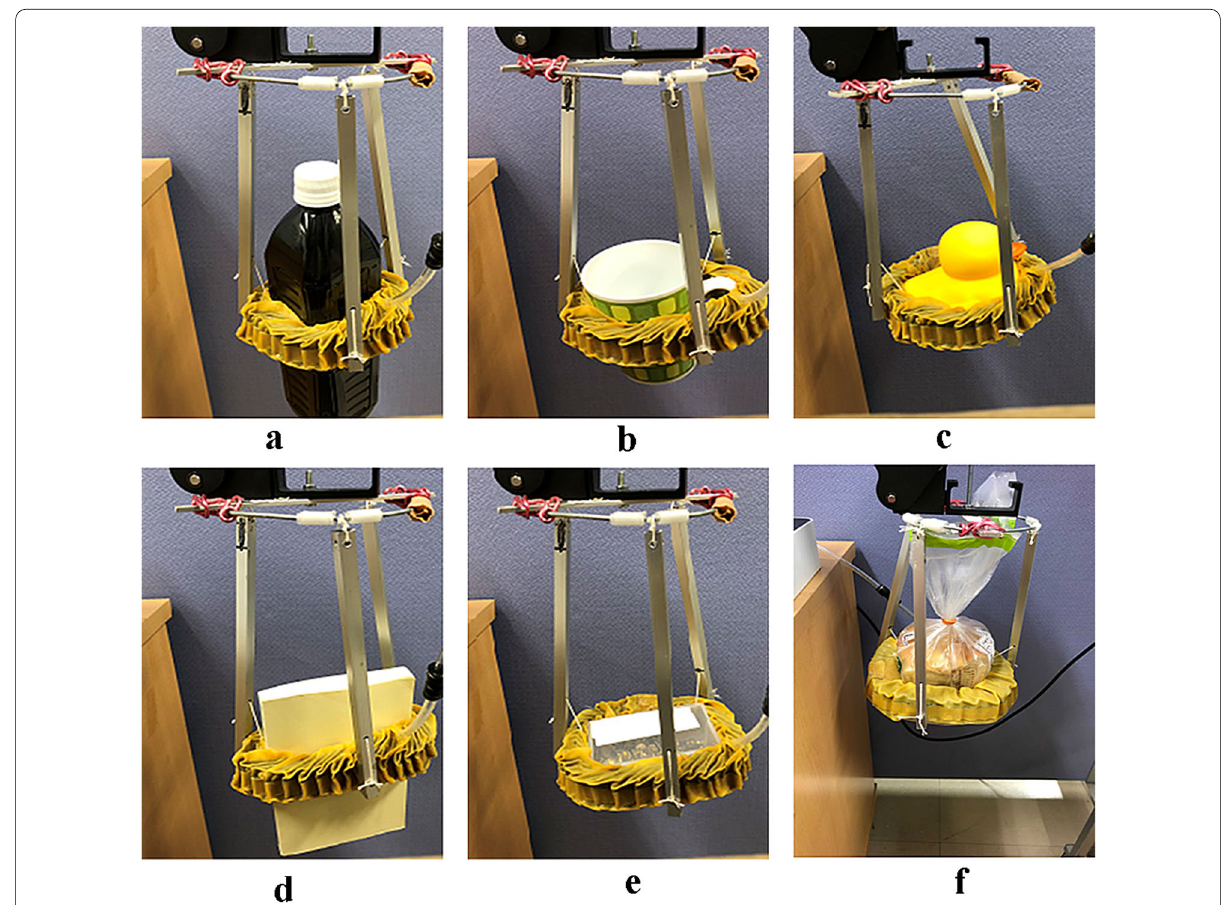
Fig. 13 The gripper picks up various objects a a bottle (950 g); b a mug (289 g); c a duck toy (61 g); d a book (185 g); e a box (144 g); f square bread loaf (146 g). The gripper was able to lift objects of various shapes by wrapping around them. For the bread, exhausting the inside air of the gripper was stopped at – 3 kPa to avoid crashing after the gripper wrapped the square bread without